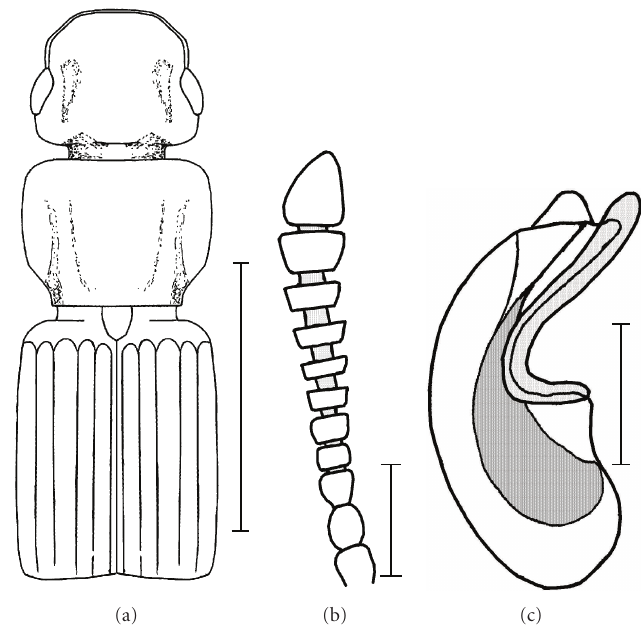
Figure 2: Fore body (a), antenna (b), and aedeagus (c) of T. venezuelanus (scale bar (a) 0.5 mm, ((b and c) 0.1 mm).